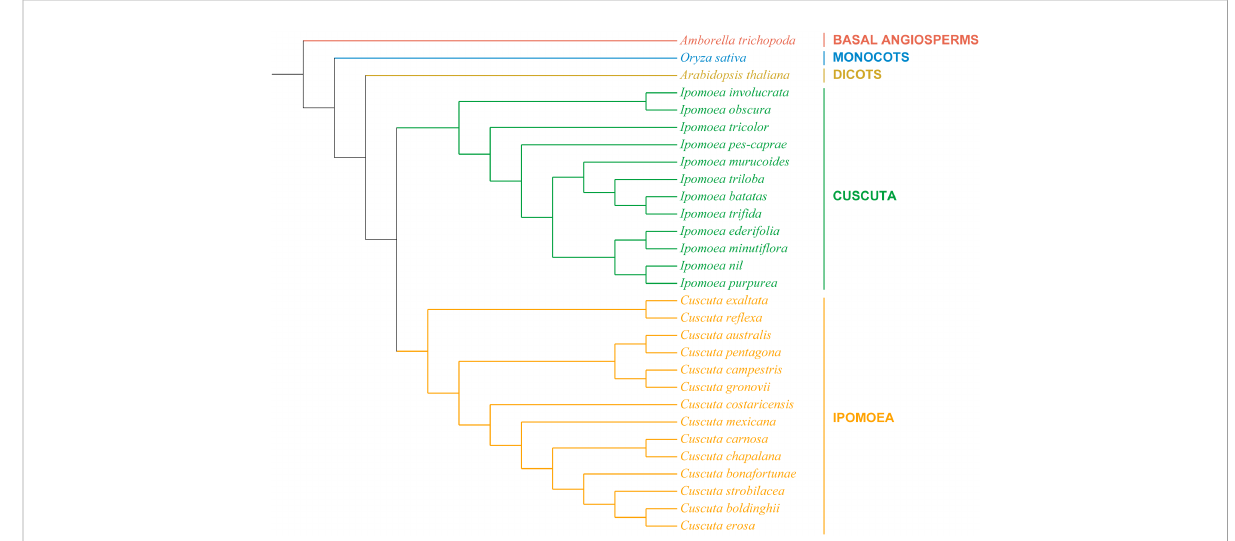
FIGURE 5 The phylogenetic relationships of the 26 Convolvulaceae species. Orthologous Single-copy genes phylogenetic tree of 26 Convolvulaceae family species and three outgroups constructed using maximum likelihood (ML)